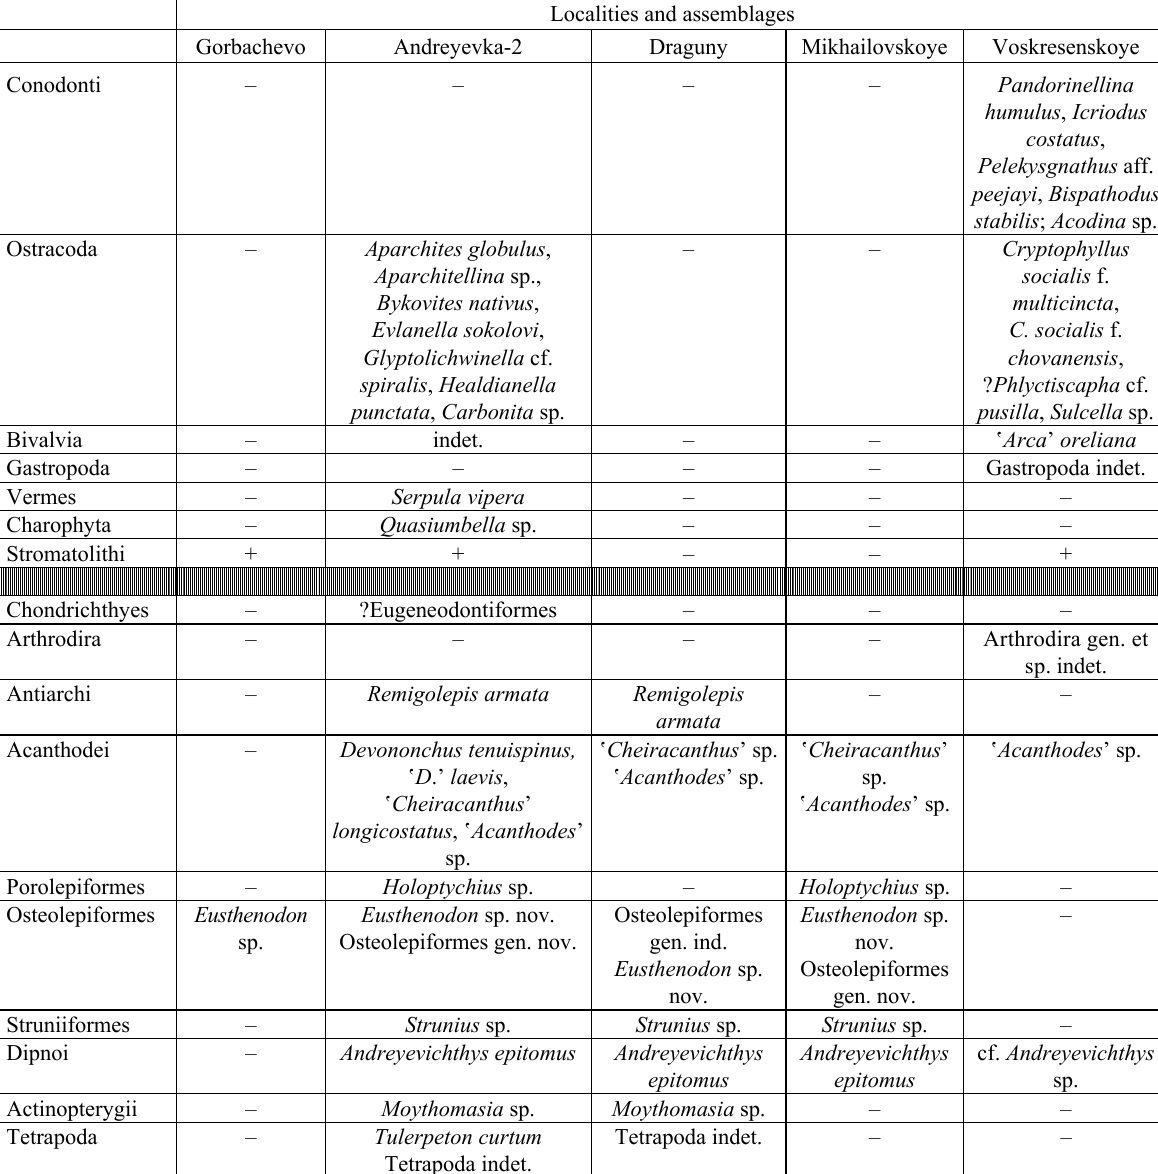
Table 1. Fossil remains in the Khovanshchinian assemblages of the Tula and Lipetsk regions of Central Russia. Data in the Andreyevka-2 locality from Alekseev et al.